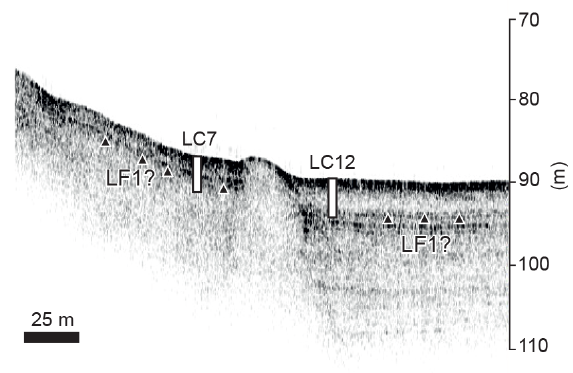
Figure 3. Sub-bottom profile across coring sites LC7 and LC12 in the central basin of Blåsø. The prominent reflector ∼ 3–4m below the lake floor (black triangles) is likely related to the deposition of lithofacies (LF) 1 during ice shelf